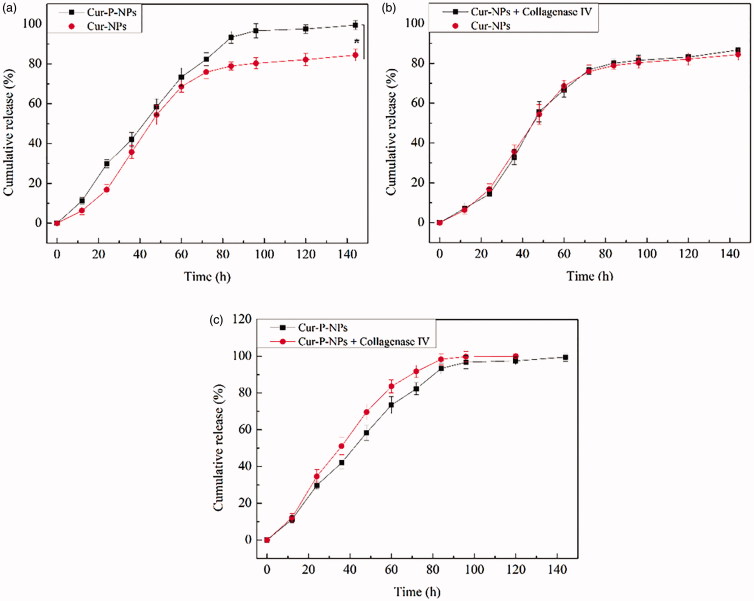
Release curve of (a) Cur-NPs and Cur-P-NPs; (b) Cur-NPs and Cur-NPs + collagenase IV;
(c) Cur-P-NPs and Cur-P-NPs + collagenase IV (*p < .05).